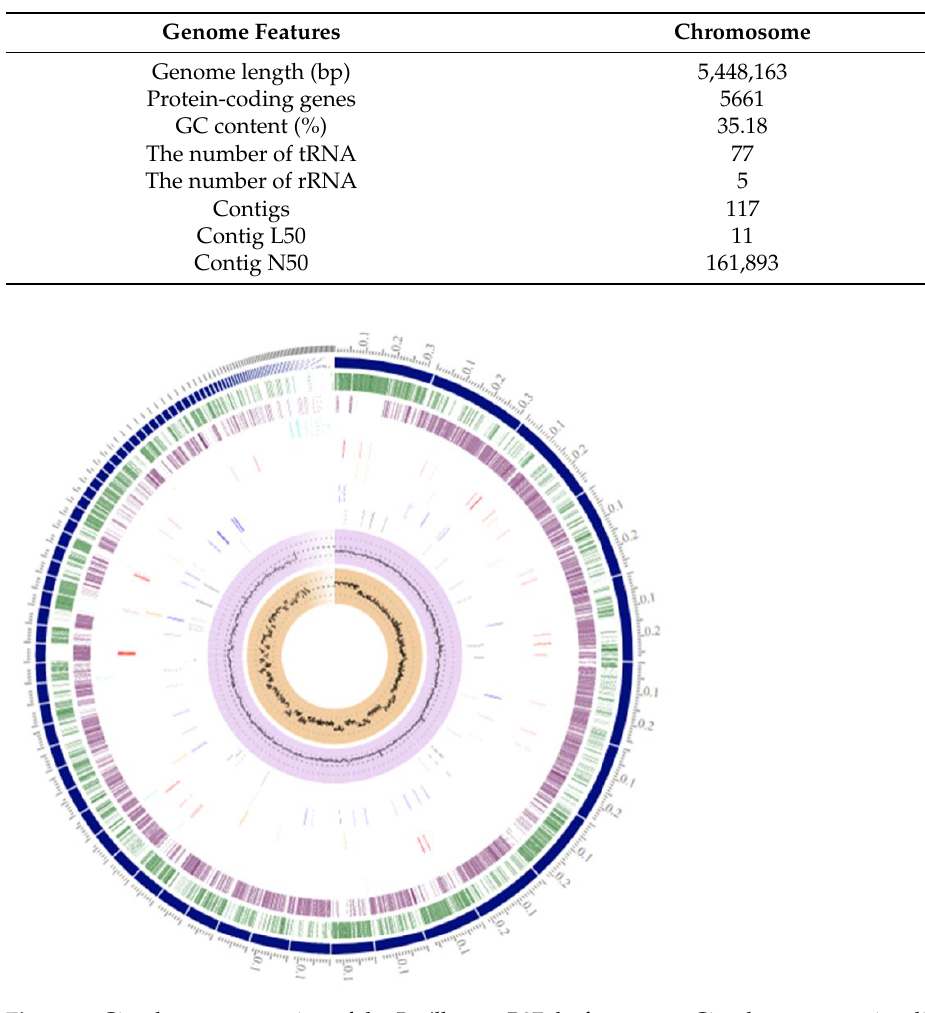
Figure 3. Overview of the subsystem categories of the annotated draft whole genome of Bacillus sp. B87 from the RAST server. The pie chart shows the number of genes related to individual subsys- tems. The bar graph on the left reveals the subsystem coverage. The ratio of coding sequences an- notated in the SEED subsystem (33%) and outside of the SEED subsystem (67%) is indicated. A phylogenetic tree based on core genes was reconstructed in PATRIC using the whole-genome sequence of Bacillus sp. B87 (Figure 4A). This phylogenomic analysis re- vealed that Bacillus sp. B87 was closely related to strains of Bacillus pacificus . The 16S rRNA